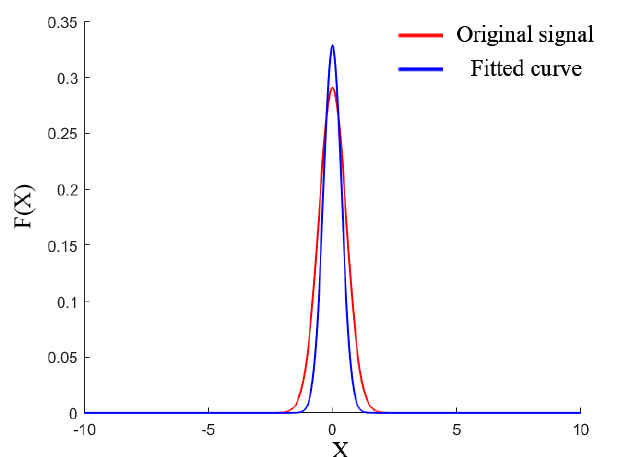
Figure 7. Fitting effect of WOA algorithm (trapped in local optimal